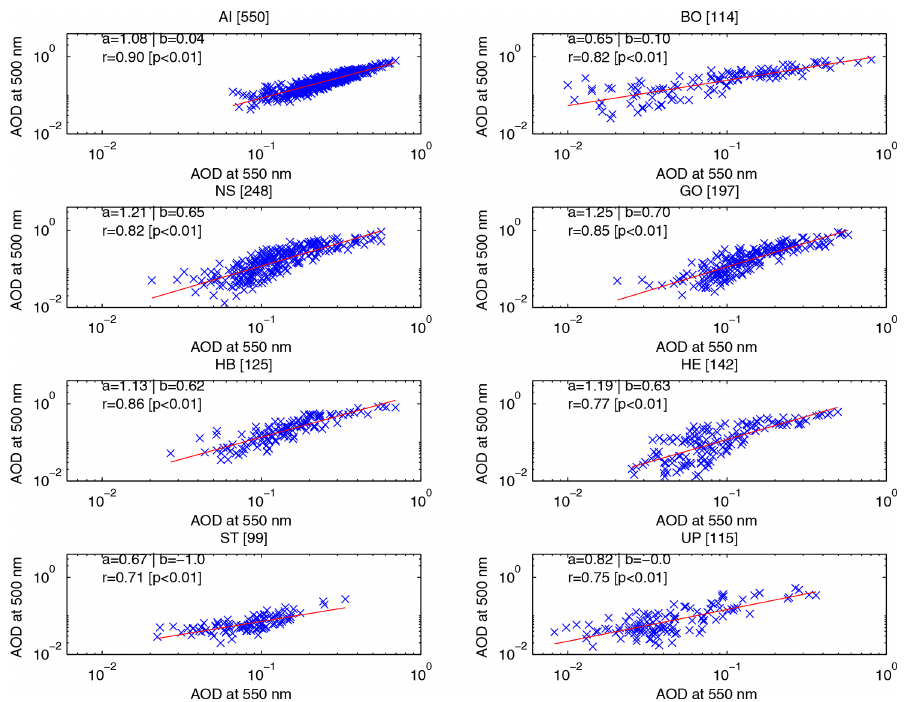
Figure 3. Daily data comparison for ASO 2003–2017: CAMS reanalysis AOD at 550nm vs. AERONET observed AOD at 500nm. CAMS data are extracted at grid points that are the closest to the station coordinates (see Table 1). Red lines display the linear regression between CAMS and AERONET data, and the coefficients of the regression models are also reported in the plots, along with the correlation coefficient and the p value. In titles, the size of the sample used in the linear regression model is reported in brackets (see Sect. 2.2 for details).